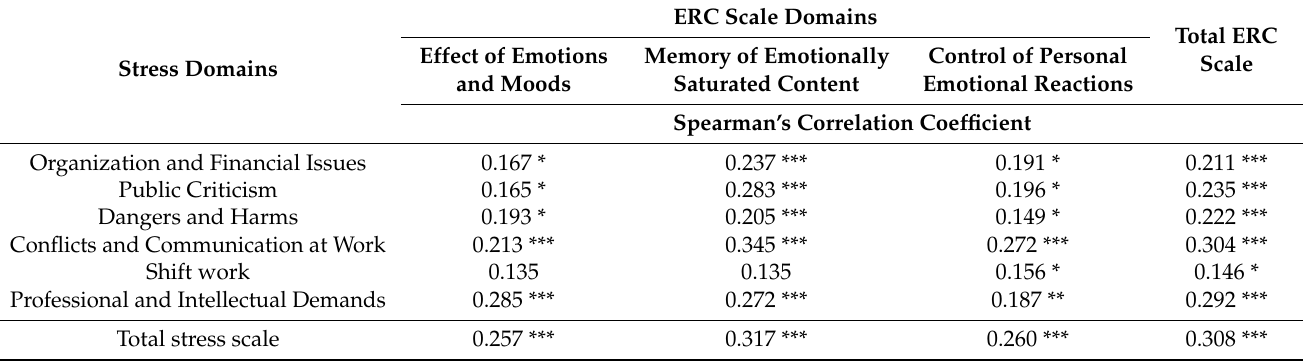
Table 5. Correlation between experienced stress and the ability of emotional regulation and